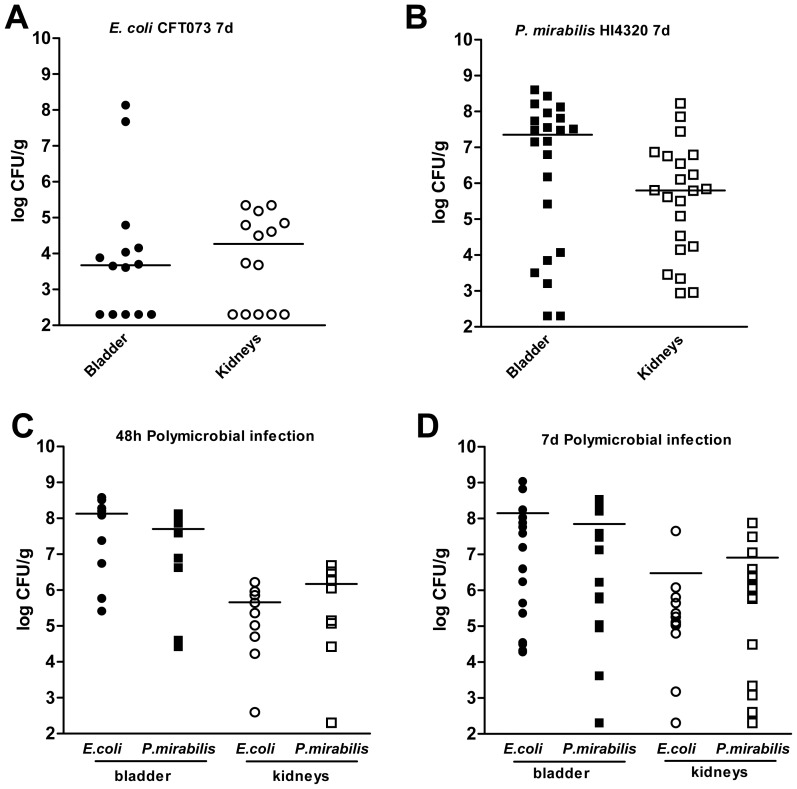
Polymicrobial urinary tract infection with E. coli and P. mirabilis enhances persistent bacterial colonization.Colonization levels following independent infections of female CBA/J mice with (A) UPEC strain CFT073 or (B) P. mirabilis HI4320. Colonization levels at (C) 48 hpi and (D) 7 dpi following polymicrobial infection of female CBA/J mice inoculated with a mixture of CFT073 and HI4320. The CFU/g of tissue for UPEC (circles) and P. mirabilis (squares) from bladders (closed symbols) and kidneys (open symbols) from individual animals at 48 hpi for (C) or 7 dpi for (A, B, D). Bars indicate the median values.